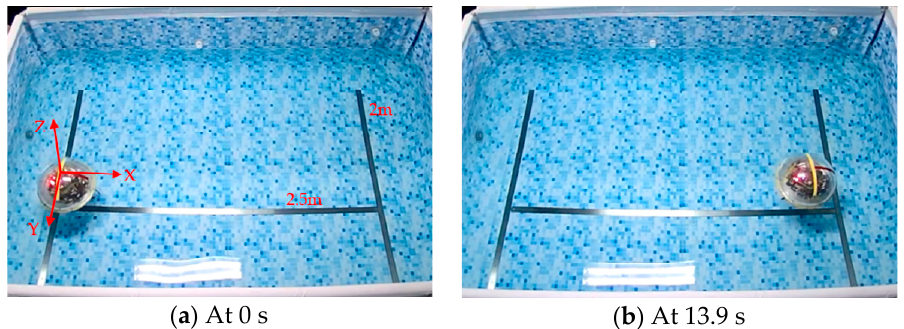
Figure 22. Underwater forward motion on the water surface.